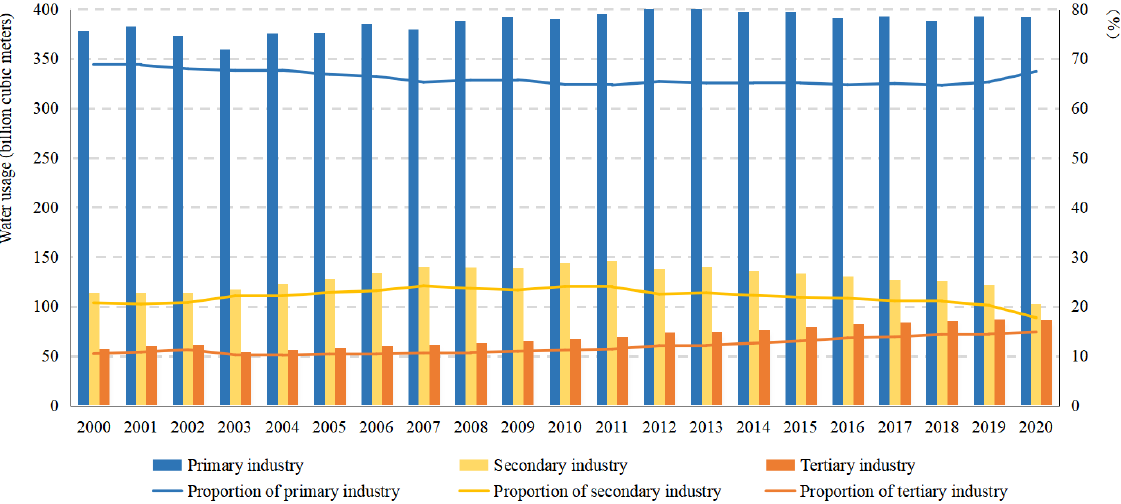
Figure 1. Water usage and proportion of various industries in China from 2000 to 2020.